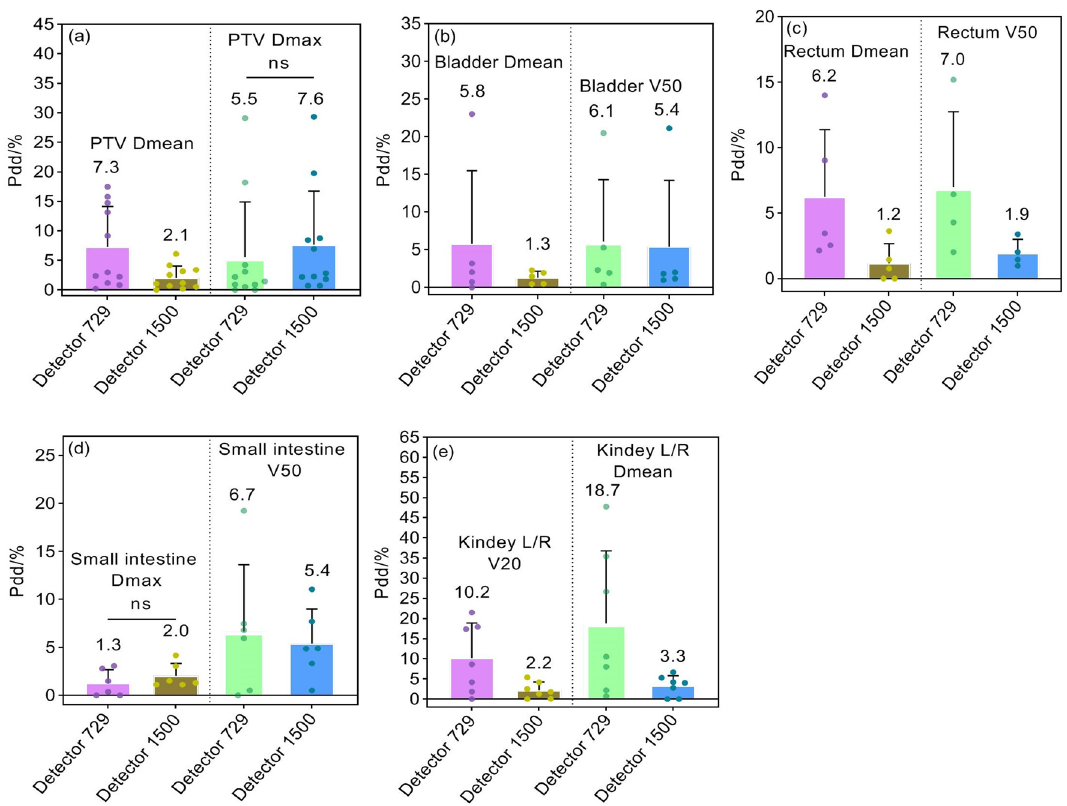
Figure 10. Pdd/% for abdomen and pelvis plans. ( a ) Percent dose deviations of mean and maximum dose in PTVs; ( b ) Percent dose deviations of mean dose and percent volume deviations exposed to a dose of 50 Gy in bladder; ( c ) Percent dose deviations of mean dose and percentage volume deviations exposed to a dose of 50 Gy in rectum; ( d ) Percent dose deviations of maximum dose and percentage volume deviations exposed to a dose of 50 Gy in small intestine; ( e ) Percent dose deviations of mean dose in bilateral kidneys and percentage volume deviations of bilateral kidneys exposed to a dose of 20